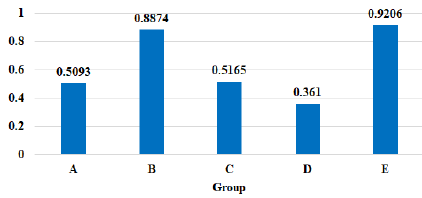
Figure 14. Angular velocity root mean square error